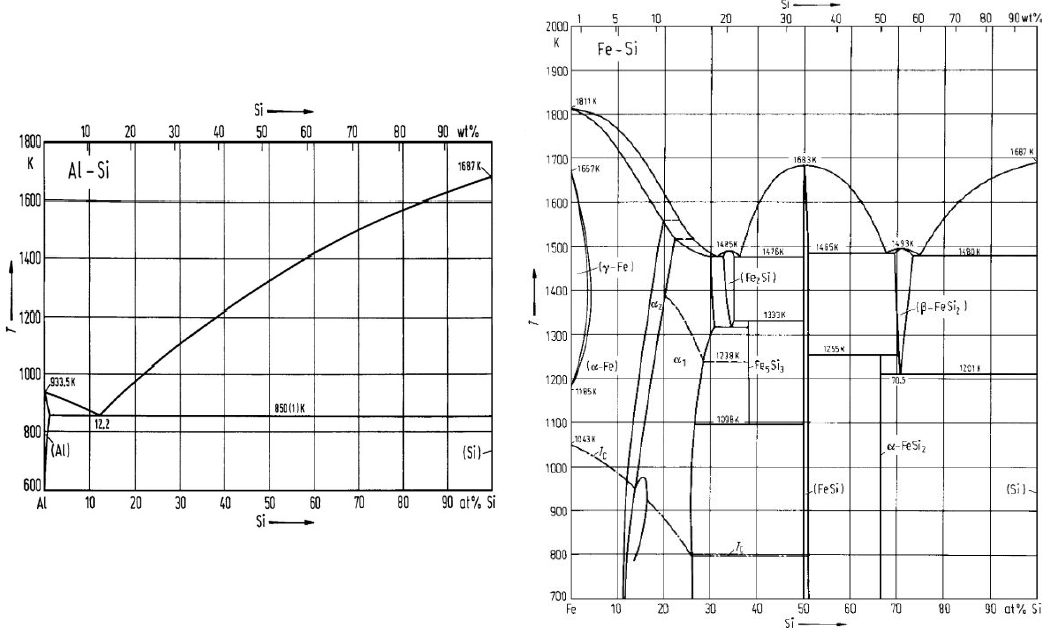
Figure 3. Binary phase diagrams of Si ‐ Al ( left ) and Si ‐ Fe ( right ) [12].